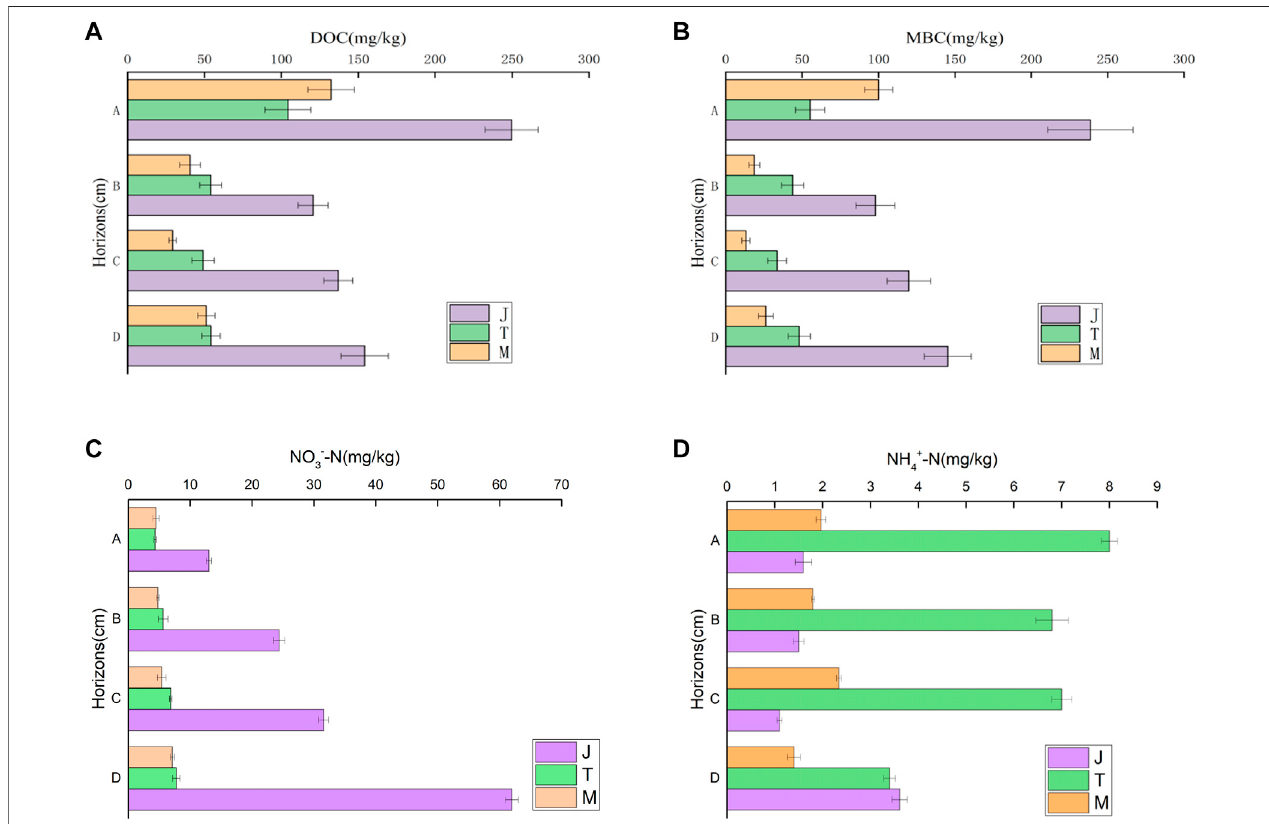
FIGURE 4 | Vertical distribution of soil microbial biomass carbon, dissolved organic carbon, ammonia nitrogen and nitrate nitrogen in peatlands of different [Permafrostregions: (A) -Dissolvedorganiccarboncontent, (B) -Microbialbiomasscarboncontent, (C) -nitratenitrogenconcentration, (D) -Ammonianitrogencontent].